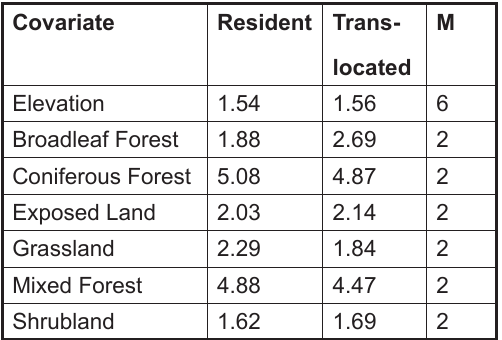
Table 3. Variance Inflation Factors (VIFs) and mini- mum number of individuals required (M) for habitat types in the top performing habitat selection model for both resident and translocated caribou in the Colum- bia North population.